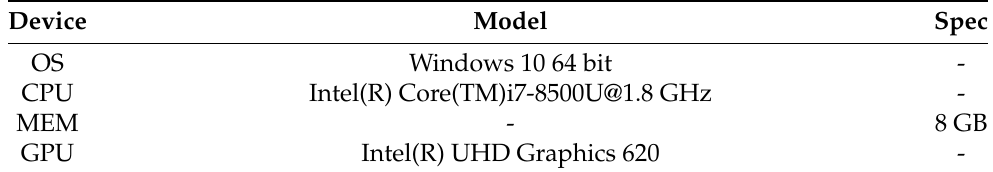
Table 7. Experimental environment.